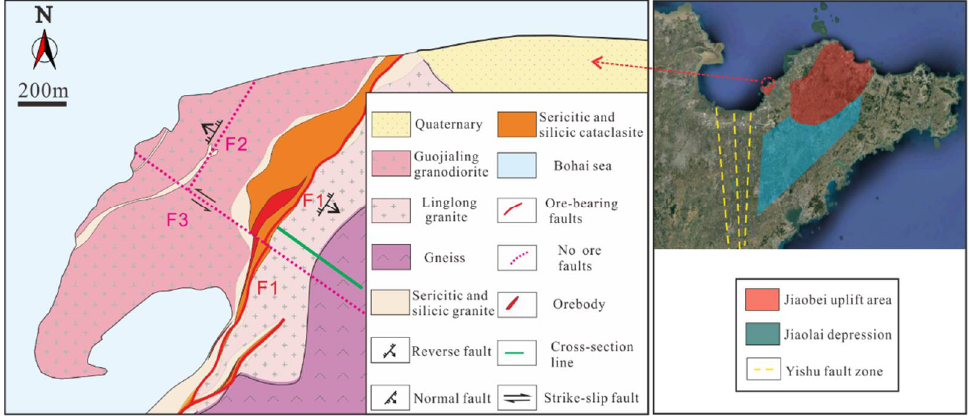
Figure 2. Simplified geological map of study area: the bedrock consists of sericitic and silicic granite, pyrite sericite, gneiss, cataclasite. The cross-section line is marked in green in the figure (adapted from [64]).